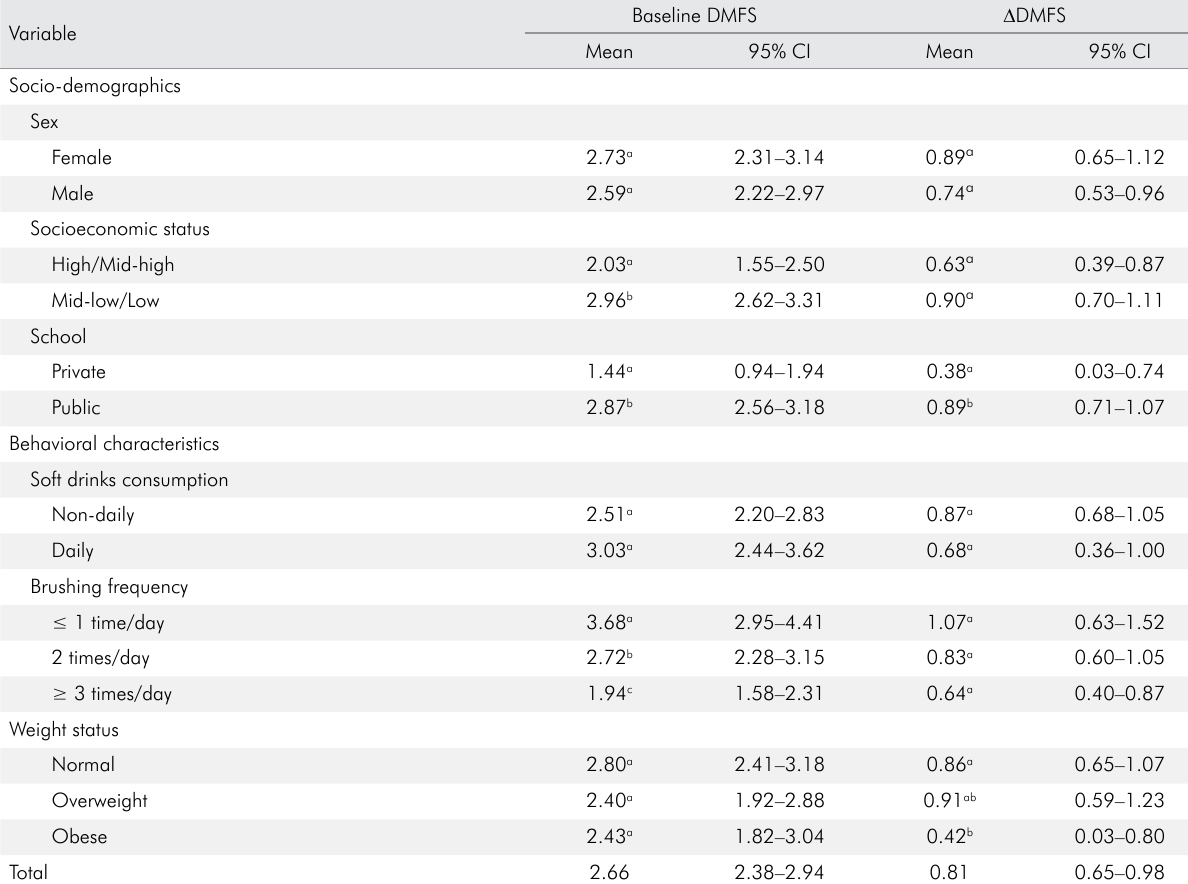
Table 2. Baseline DMFS and Δ DMFS by predictor variables (n =